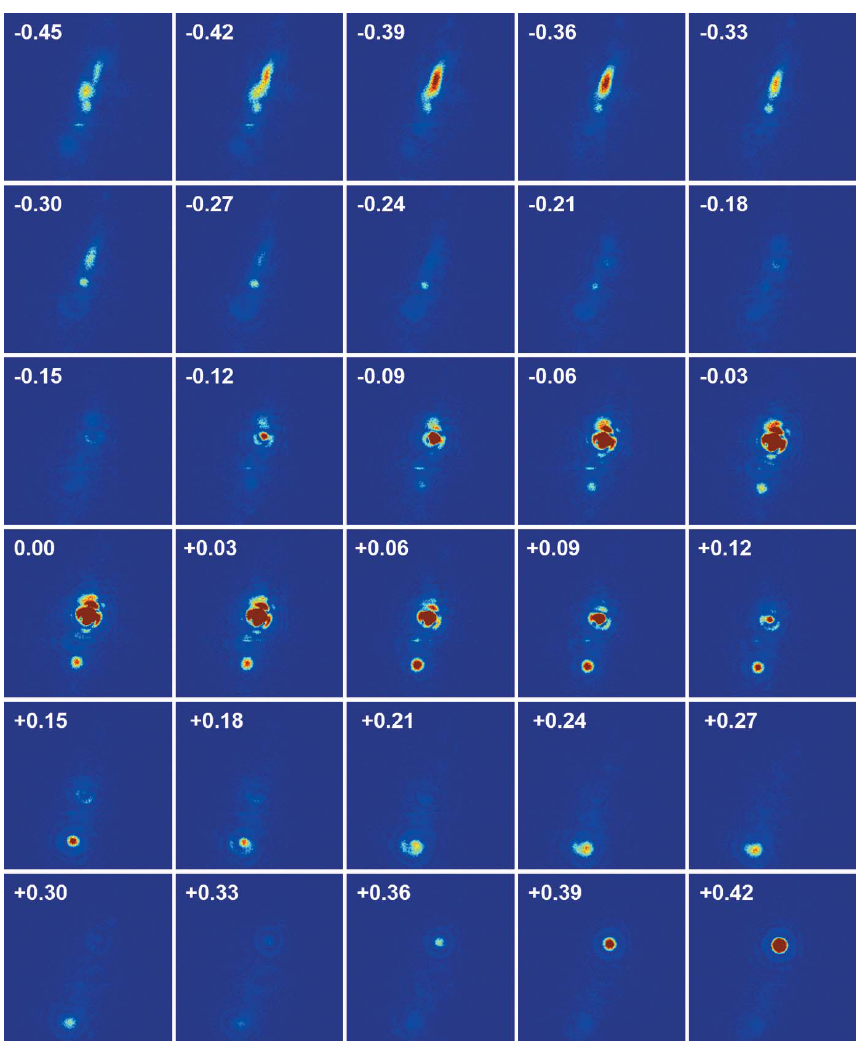
Figure 8 The diffraction patterns of Au nanocrystals were recorded while rotating the sample through Bragg diffraction conditions near the off-specular Au(11 (cid:2) 11) Bragg peak. Actually, the (cid:2) -rocking angle is (cid:6) 0.5 (cid:2) with a step of 0.01 (cid:2) . The values shown in the figure represent the rocking angle. Data contain 161 (cid:5) 161 pixels corresponding to (cid:3) Q = (cid:6) 0.0237 A˚ (cid:3) 1